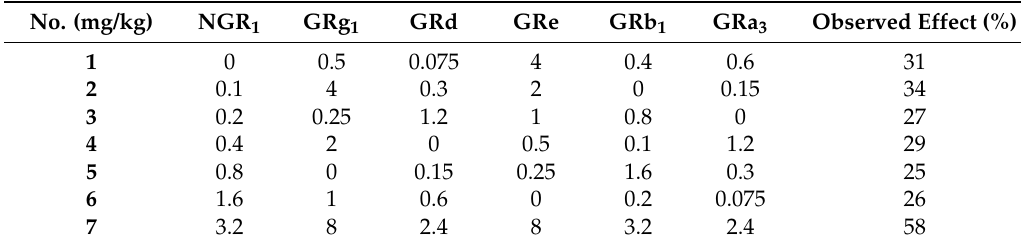
Table 3. The uniform design and the observed anti-platelet aggregation effect of seven different individual saponin combinations in vivo study in example